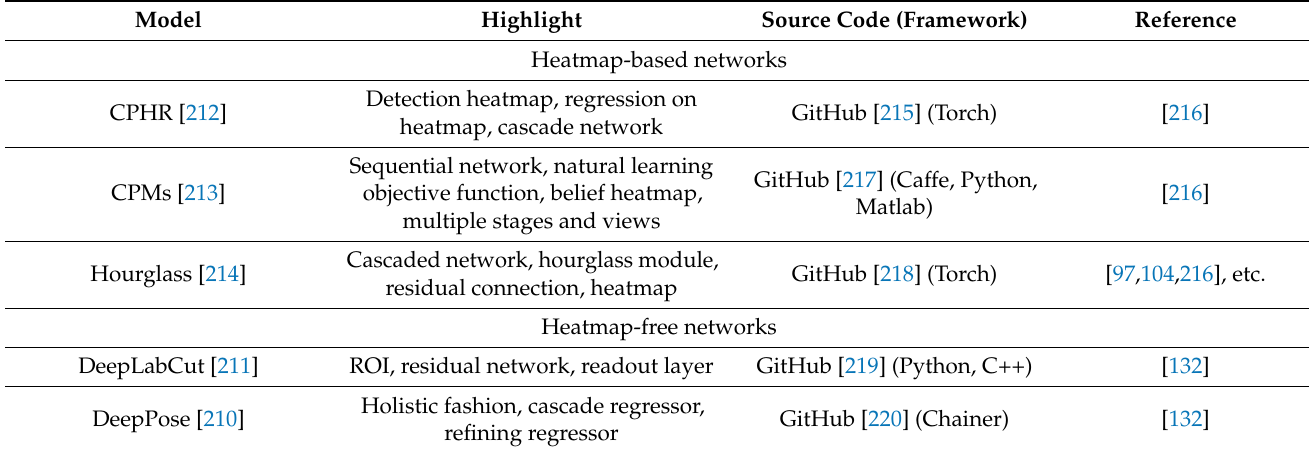
Table 6. Convolutional neural network architectures for pose